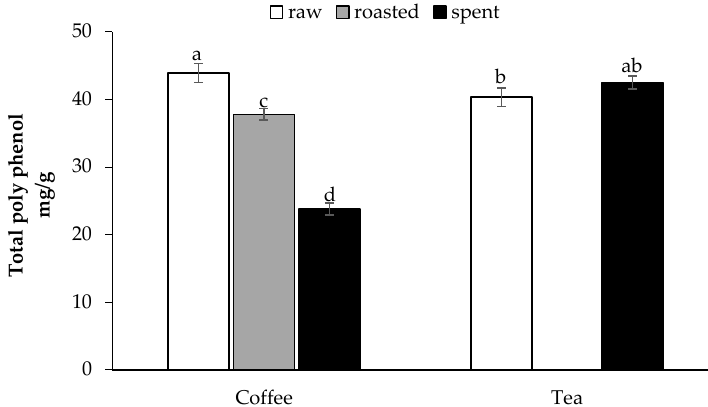
Figure 2. Total polyphenols (mg/g) content of spent coffee and black tea waste. Data represent the mean ± SD ( n = 3). a–d Means with different letters are significantly different ( p ≤ 0.05) as assessed by LSD.